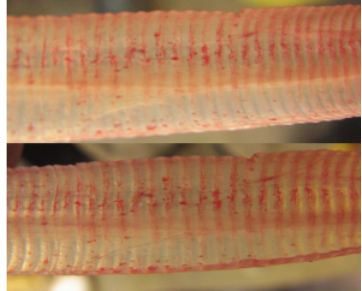
Figure 1: The tracheal mucosa shows slightly hyperemia and pete- chial hemorrhages on 1 day PI of the virus.